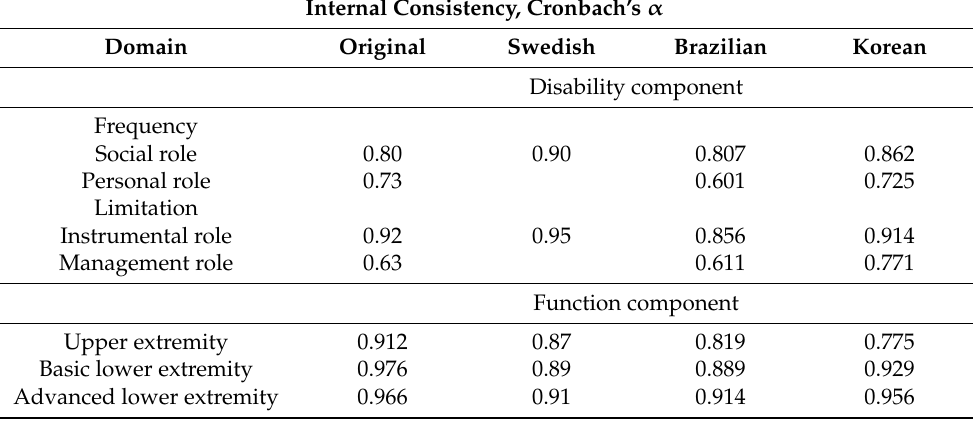
Table 3. Internal consistency of the